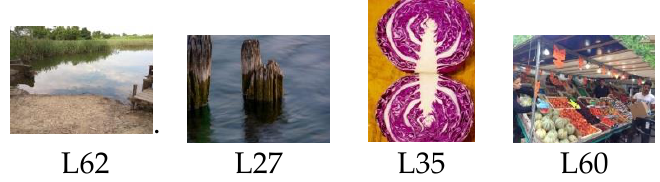
Figure 6. Recommended pictures with a grand average value >4, but not all adjective average values >4. Table 1. SD assessment results.